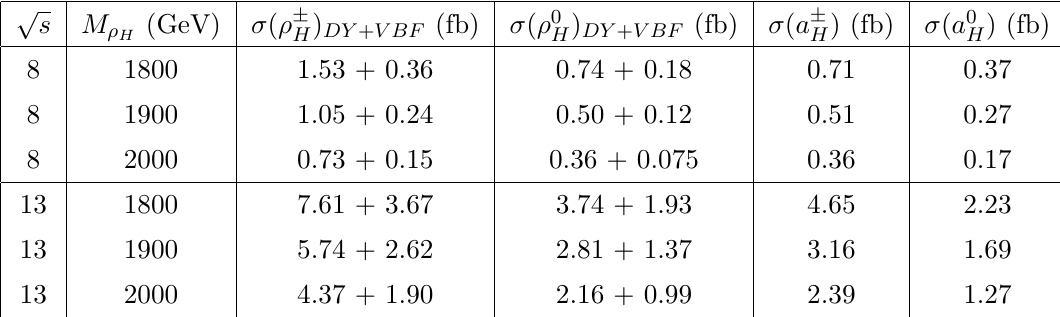
Table 3 . Production cross sections at the LHC of the isovector bosons (cid:26) H and a H for g (cid:26) and M a = 1 : 05 M (cid:26) ( (cid:26) (cid:6) = (cid:26) + + (cid:26) (cid:0) ). The individual DY + VBF contributions are given for (cid:26) H ; H H H H H the VBF rates for a H are very small and not given. For g (cid:26) = 2 : 73, (cid:27) ( (cid:26) H ! V V ) is 50% larger, H (cid:27) ( a H ! V H ) is doubled, and their widths are half as large as in table 2. No K -factor has been applied to the cross sections; from ref.